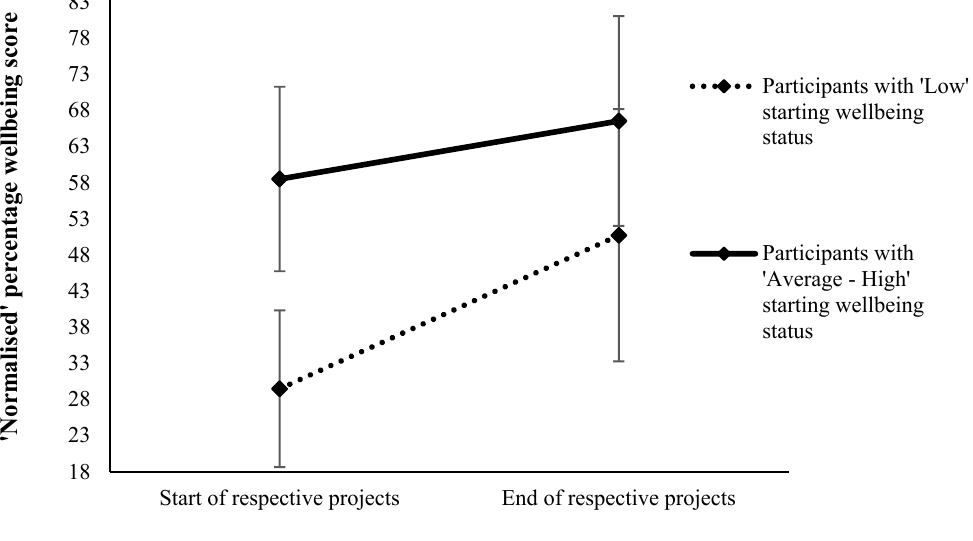
Figure 2. ‘Normalised’ percentage wellbeing scores by time-point across projects and categorised starting wellbeing status